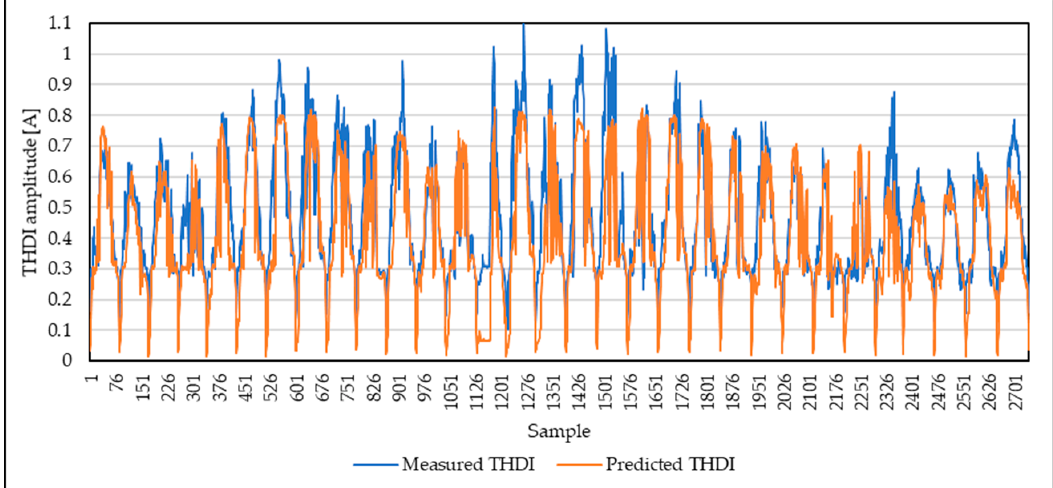
Figure 17. Time series plot of the measured and predicted THDI by the MLPNN 6 model.